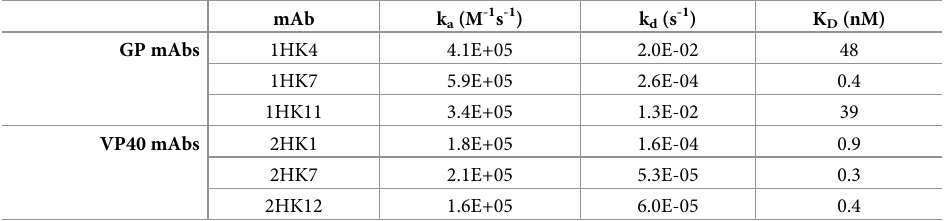
Table 4. Surface plasmon resonance analysis of EBOV monoclonal antibody (mAb) binding to nano-Ebola virus- like particles.